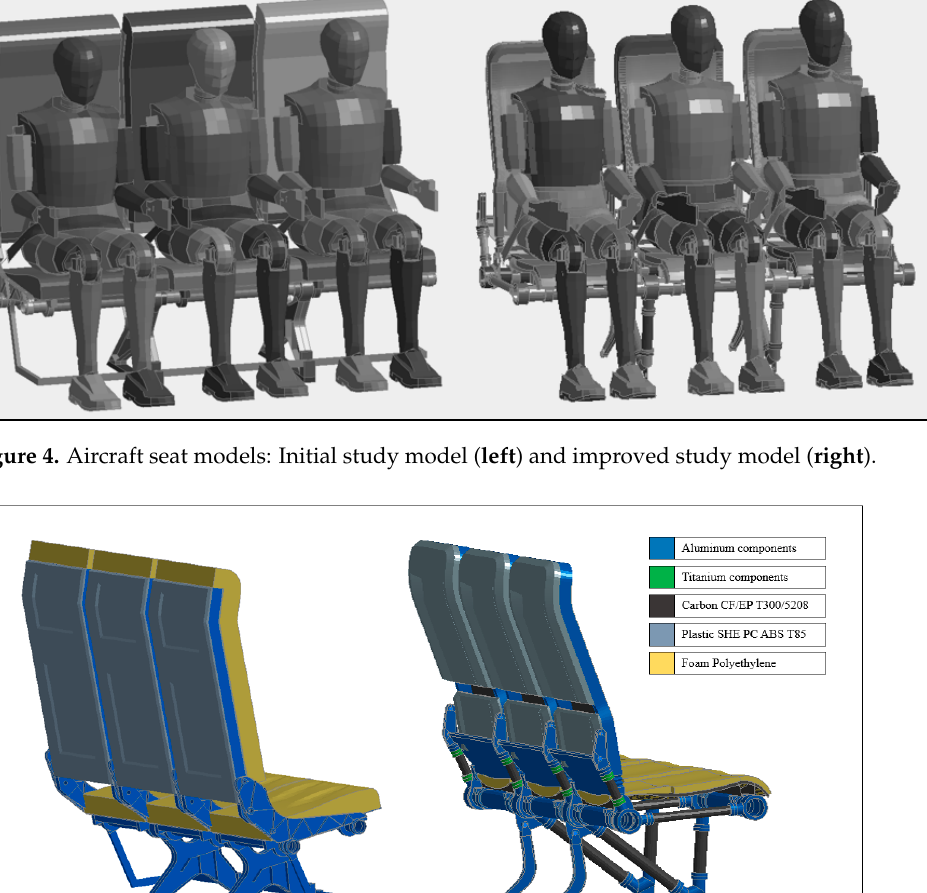
Figure 4. Aircraft seat models: Initial study model (left) and improved study model (right).